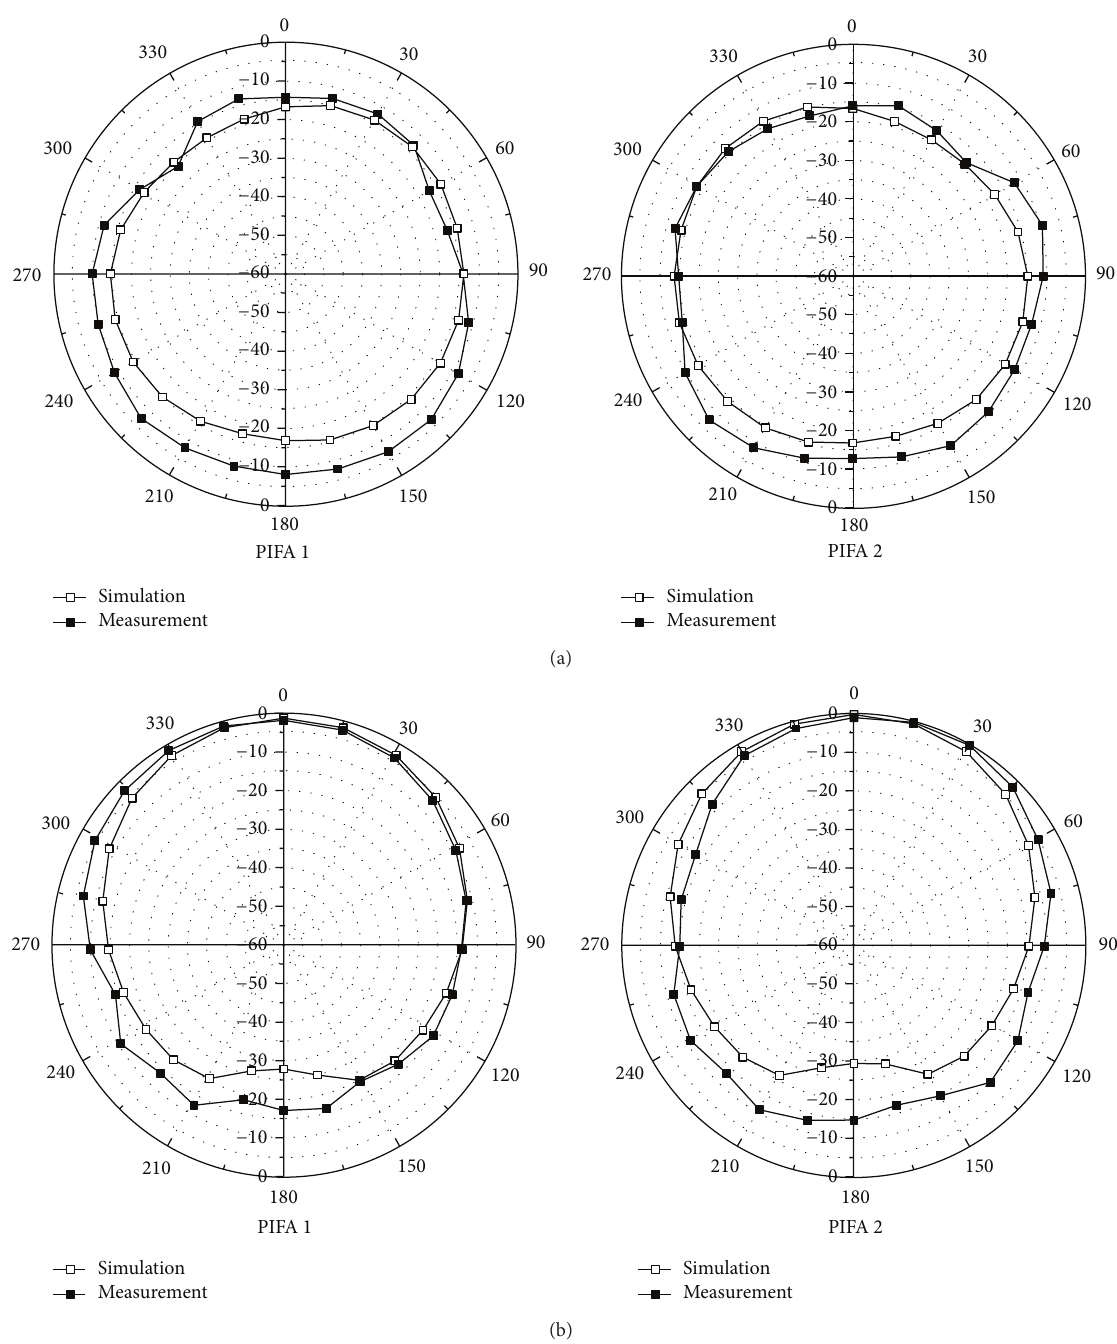
Figure 13: Simulated and measured radiation patterns of the proposed antenna at 2.44 GHz (a) 𝑥𝑦 plane and (b) 𝑦𝑧